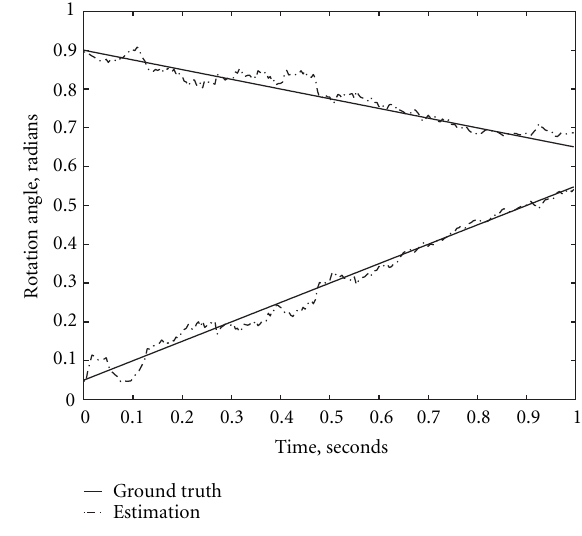
Figure 5: Rotating sensor motion